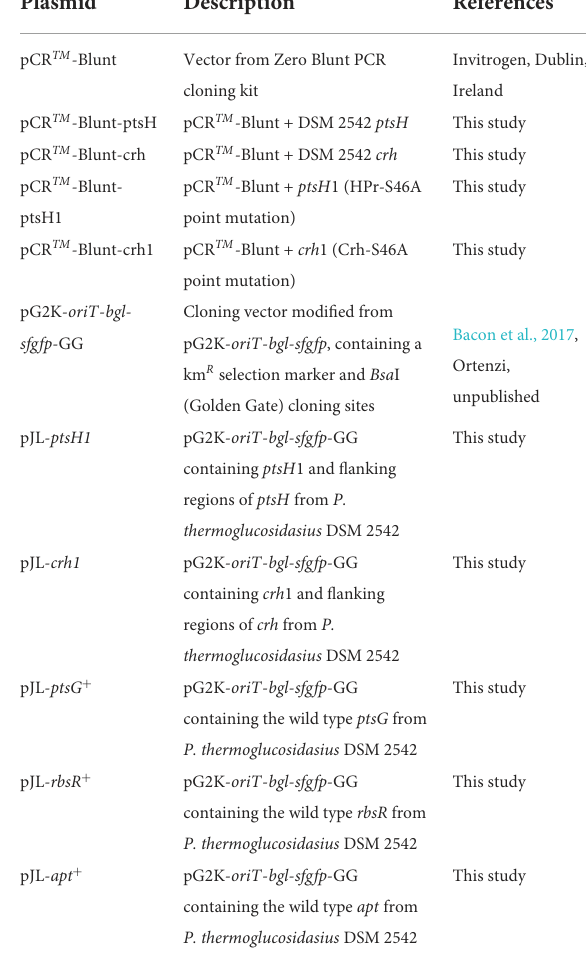
TABLE 1 Bacterial strains used in this study.